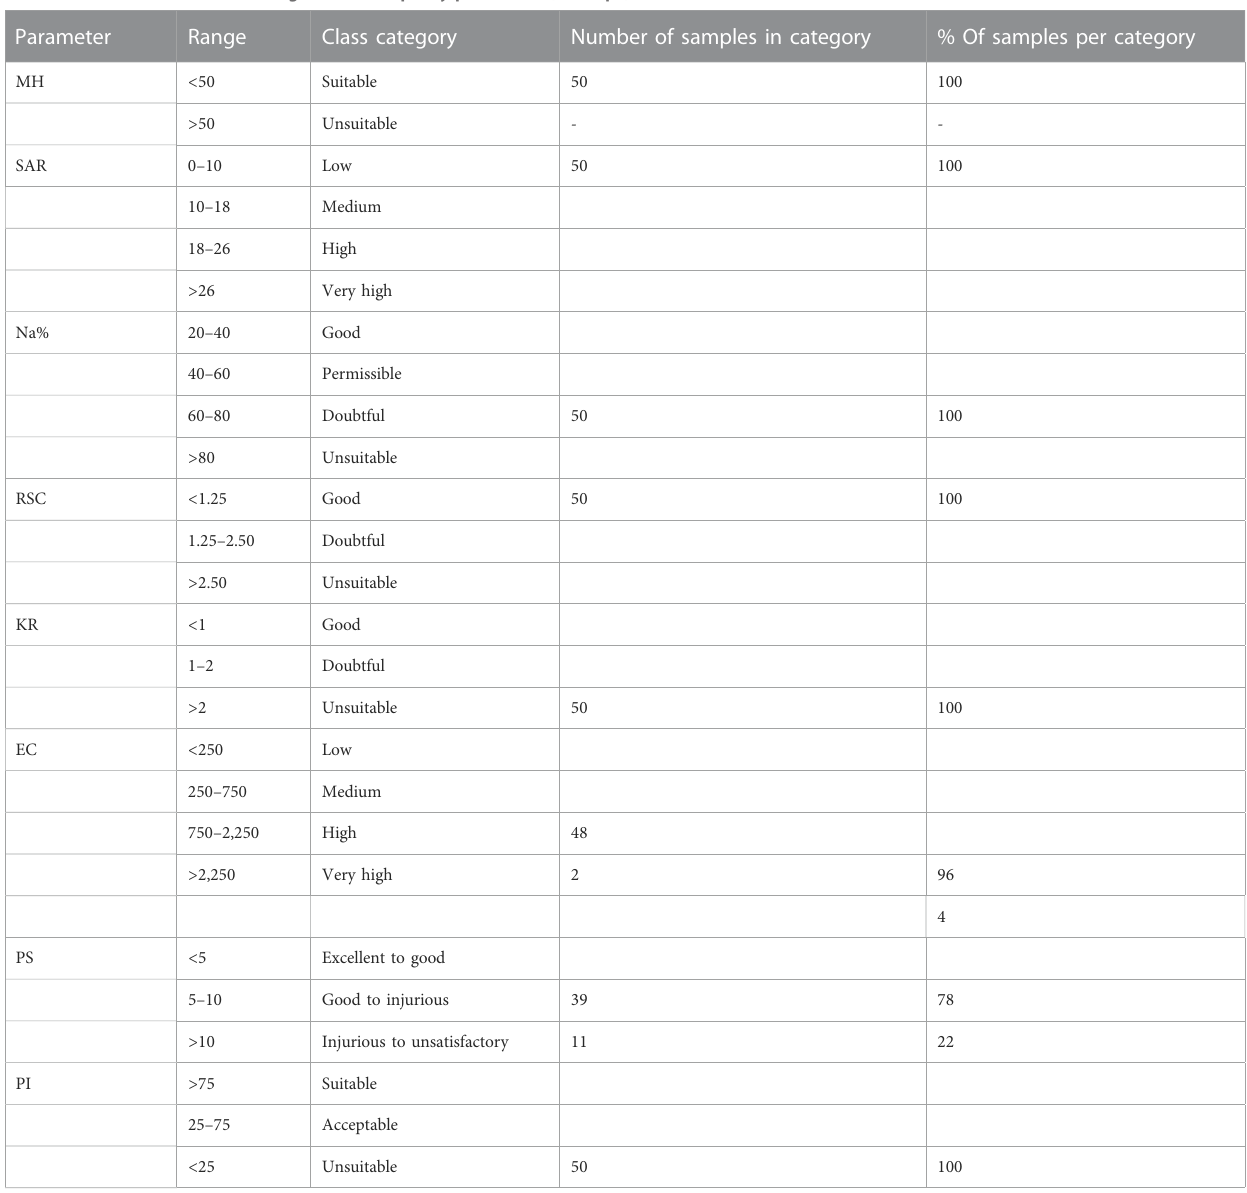
TABLE 6 Classi fi cation criteria of irrigation water quality parameters (in meq/L).